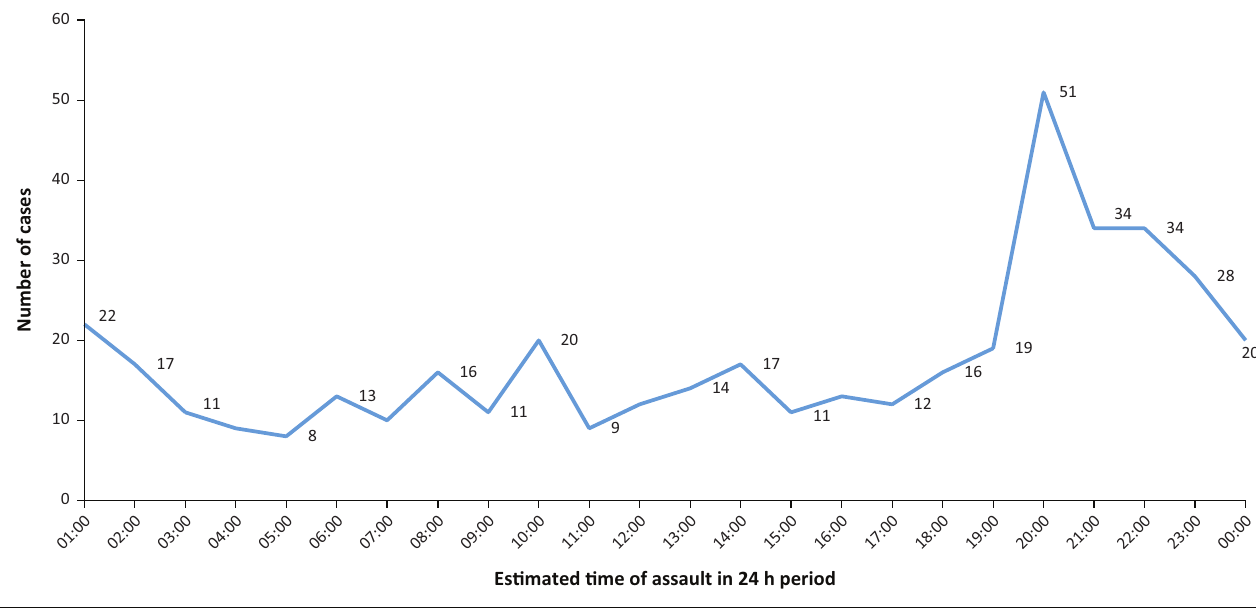
FIGURE 2: Estimated time of emergency department visits following interpersonal